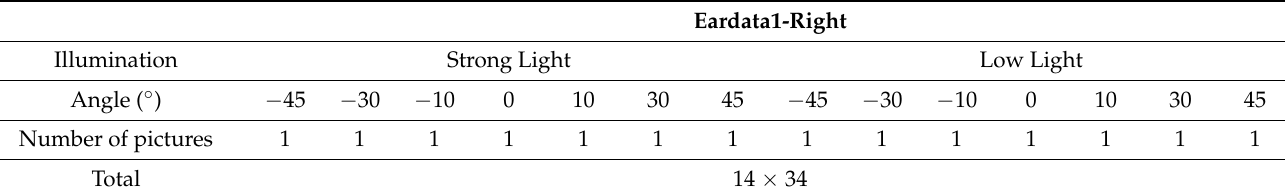
Table 4. Human ear database information of